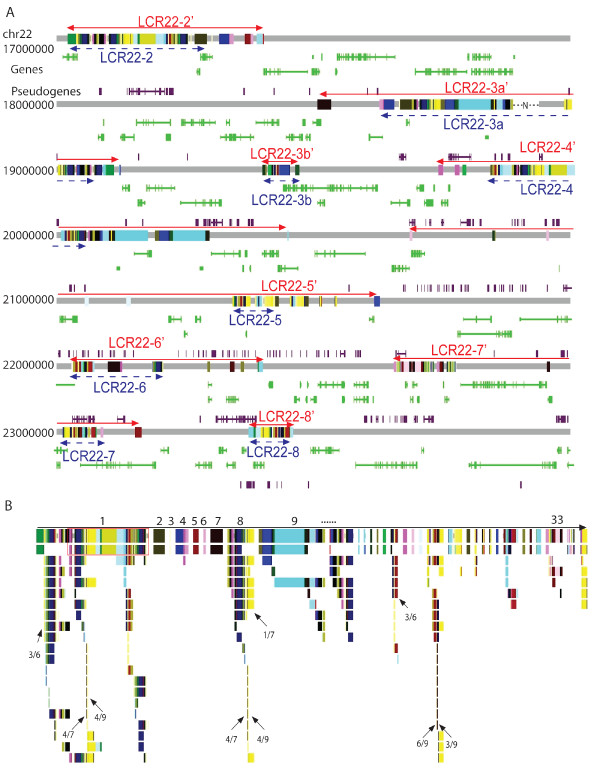
The mosaic architecture of segmental duplications in the human 22q11.2 region. (A) Duplicated subunits, genes and pseudogenes. The 22q11.2 region is depicted as a grey line and colored boxes for unique and SD sequences, respectively. Eight duplicated blocks are labelled with red arrow lines for current boundary definition (Table 1) and blue arrow lines for the previous definition [14]. Paralogous subunits (i.e., in the same subunit family) are shown with same color. For simplification, both genes (green) and pseudogenes (purple) were drawn without names. (B) Hierarchy of non-overlapping duplicated loci. A total of 33 groups of duplication loci in 22q11.2 were identified and all loci were aligned to the largest locus of their corresponding groups (all subunits have the same color as in Figure 2A). Horizontal order shows relative chromosome locations with white spaces added to separate sequences in distinct duplication groups. Arrows point to paralogous subunits at the breakpoints of recurrent (> 5) duplications; numbers below them are the total subunits at breakpoints and subsets with Alu elements. A gap in LCR22-3a' was represented by a dash line with 'N'.